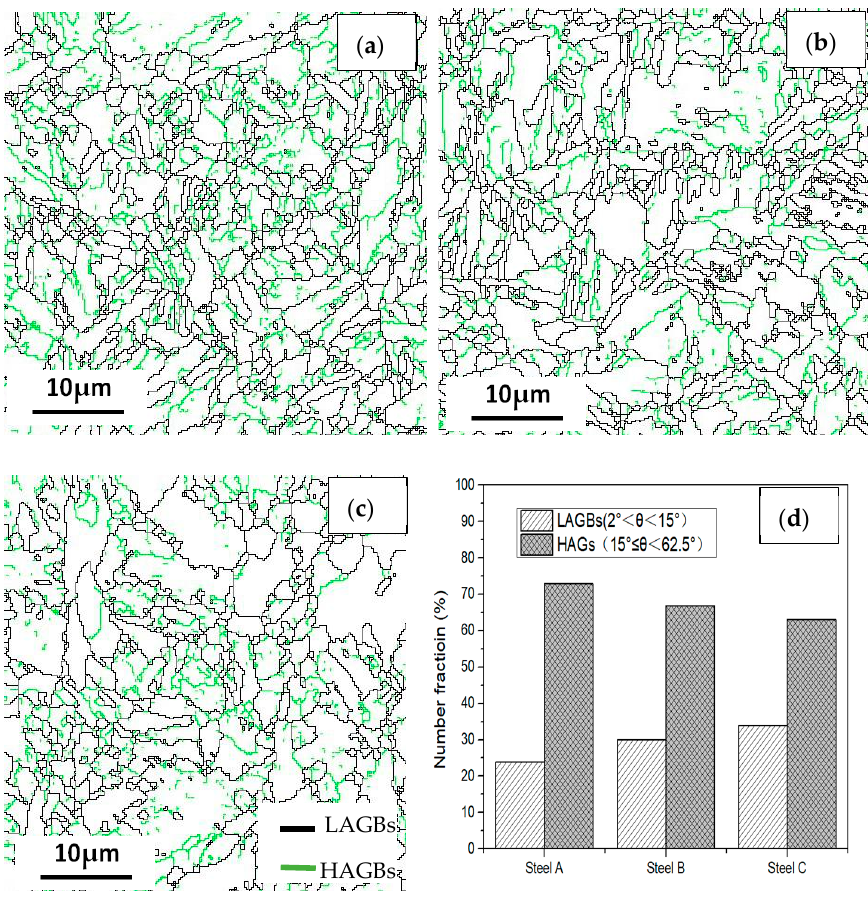
Figure 13. Grain boundary distributions of the ( a ) steel A, ( b ) steel B and ( c ) steel C specimens; and ( d ) the histograms showing their LAGBs and HAGBs number fractions.